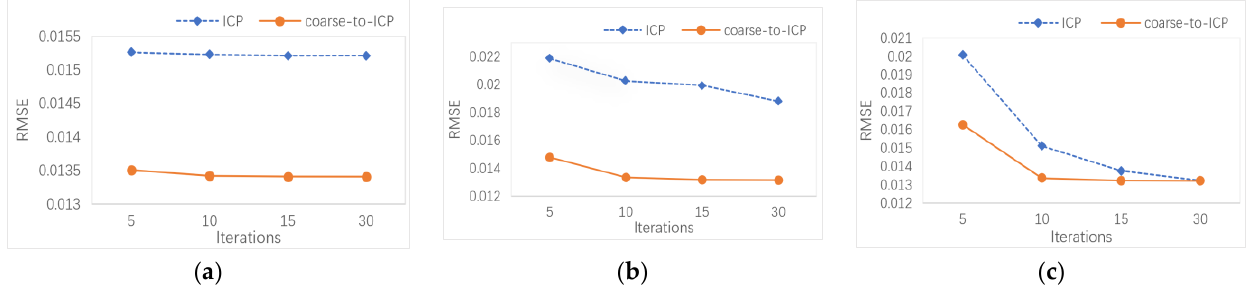
Figure 8. The RMSE records of ICP and coarse-to-ICP with different iterations. ( a ) RMSE values of ICP and coarse-to-ICP for bun045 and bun090 with 5, 10, 15, 30 iteration number. ( b ) RMSE values of ICP and coarse-to-ICP for dragon000 and magnified twice dragon048 with 5, 10, 15, 30 iteration number. ( c ) RMSE values of ICP and coarse-to-ICP for face000 and face045 with 5, 10, 15, 30 iteration number.